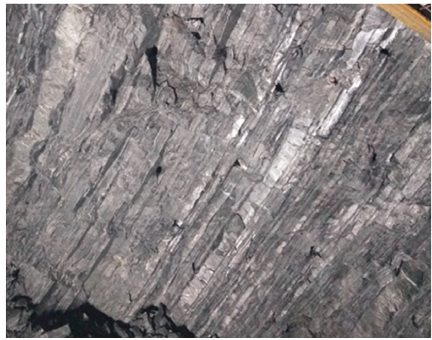
Figure 2: Tunnel exposure of carbonaceous